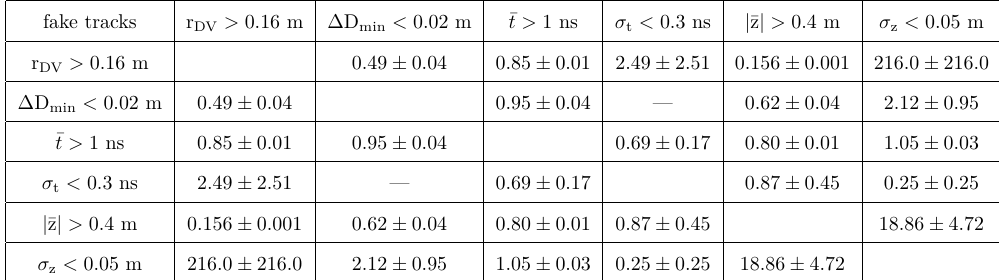
Table 3 . The correlation table for vertexing-cuts variables for the fake-track background. The entries with “—” contain too few events to make a reliable estimate and the statistical uncertainties are given after ± .